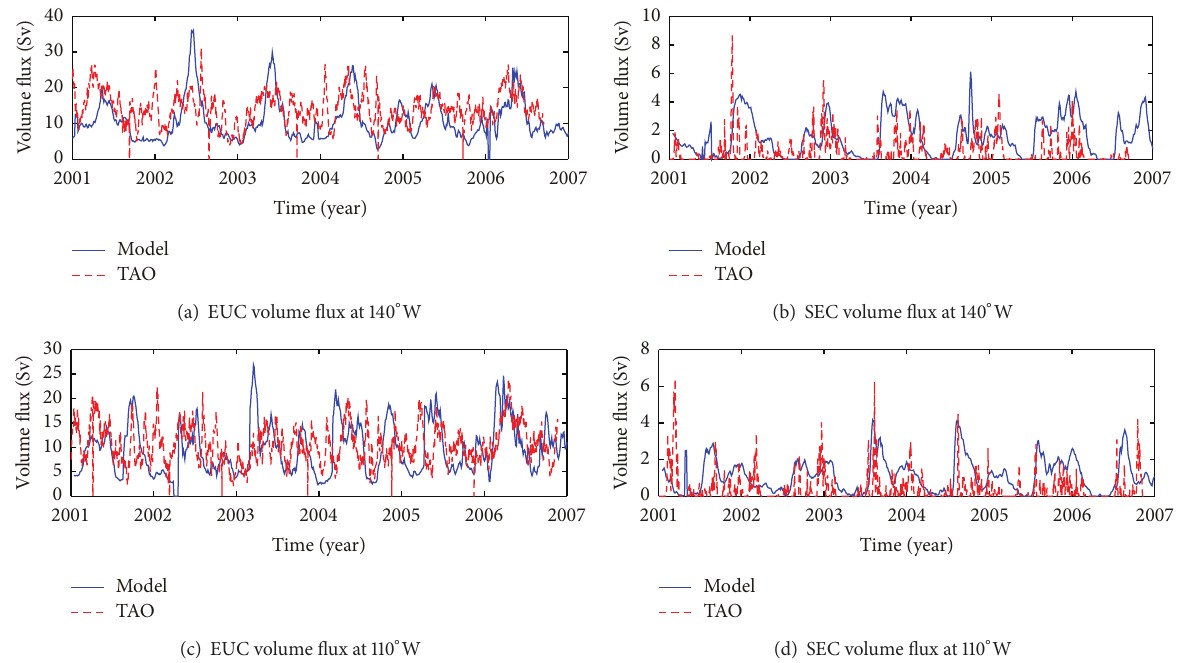
Figure 20: The compared model and observational EUC (SEC) volume flux transport at 140 ∘ W and 110 ∘ W, respectively.